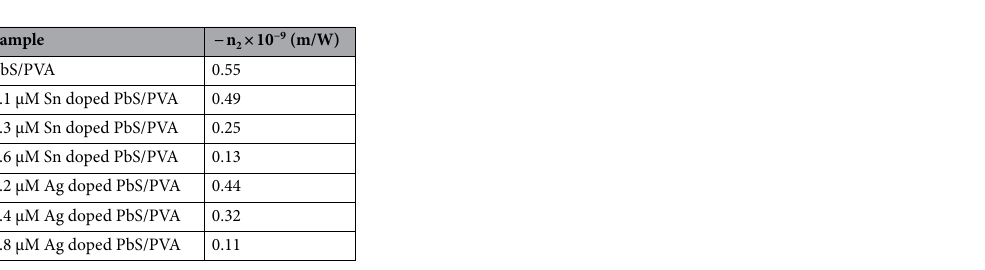
Table 2. Numerical values for the nonlinear refractive index of PVA/PbS and Sn and Ag-doped PVA/PbS.